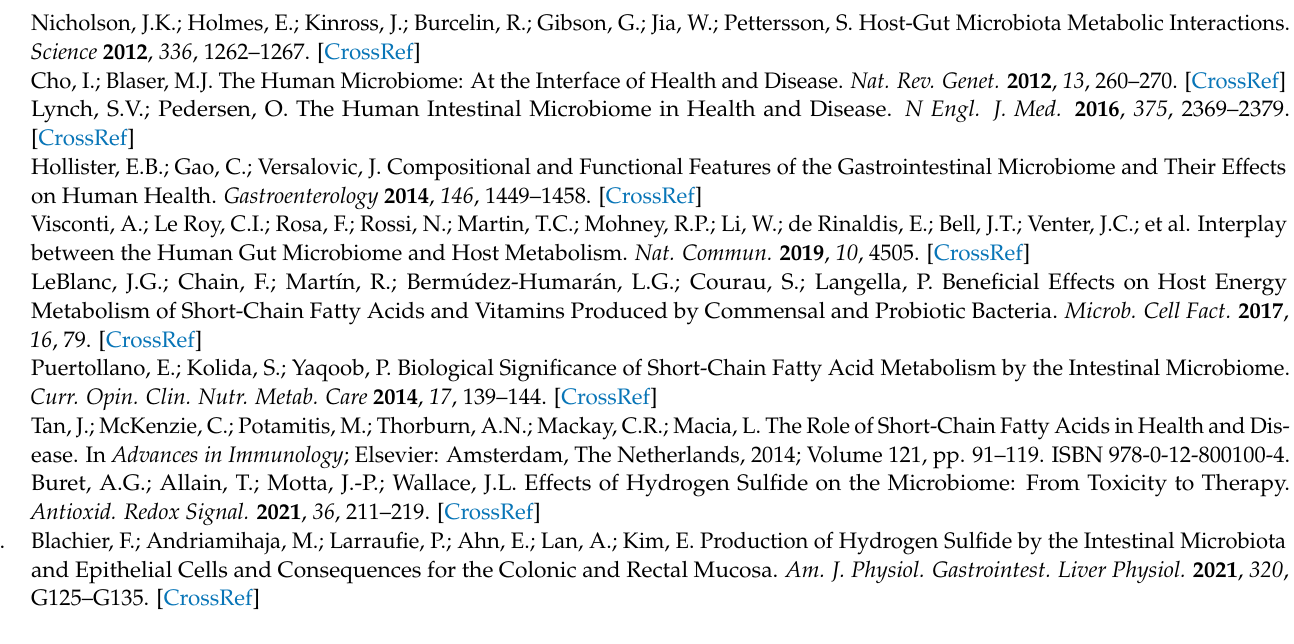
richness associations; Table S6: Overview on performances on predicting metabolite concentrations from genus abundances via elastic net regression methodologies; Table S7: Sample characteristics